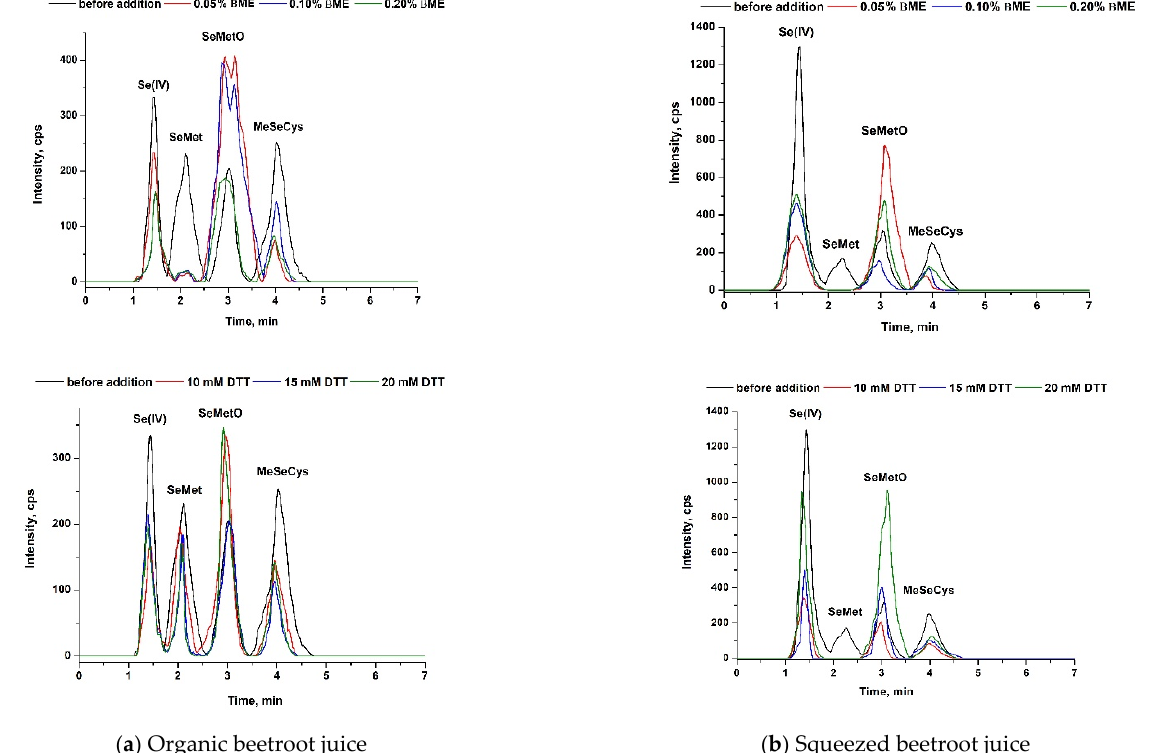
Figure 2. Chromatograms of selenium species in ( a ) organic and ( b ) squeezed beetroot juices after the addition of different concentration of DTT or β ME thiols. Storage temperature 20 °C. The ZIC-HILIC column with eluent—MeOH/H 2 O (85/15) ( v / v ). The data and the relevant statistical analysis are presented in Table S1.